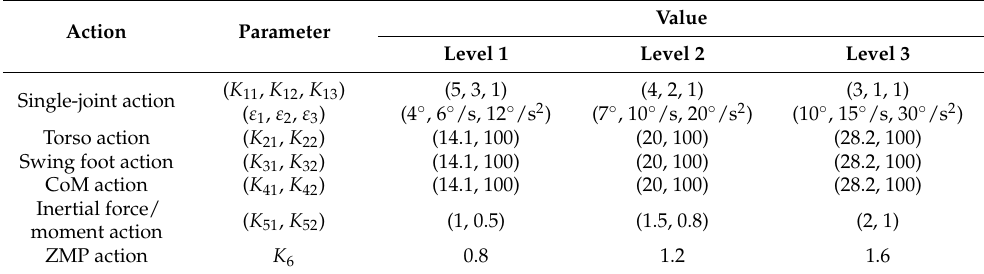
Table 6. Different levels of parameters for